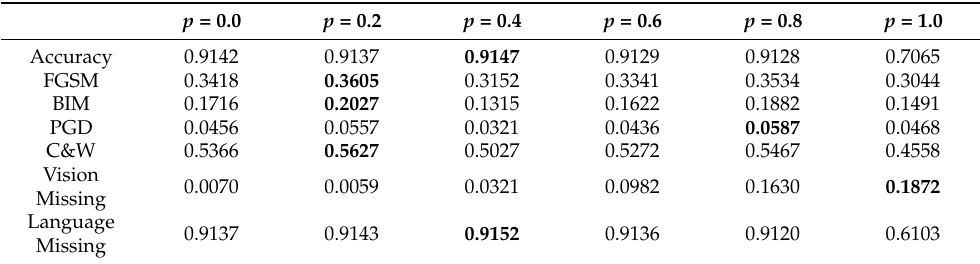
Figure 5. The accuracy trend of the probability of modality deactivation p . ( a ) Birds. ( b ) Flowers. Table 6. Accuracy averages for different cases with different values of the modal deactivation probability p for the Birds data set.